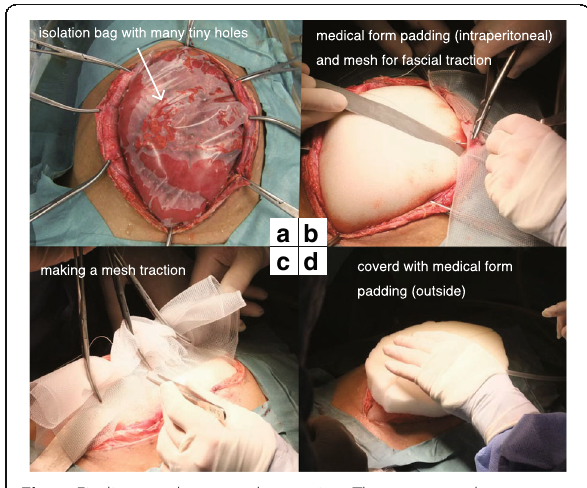
Fig. 4 Findings at the second operation. The gut was edematous and the wound could not be closed. Thus, mesh traction was performed. a The gut edema did not improve at all. b , c Medical form padding (intraperitoneal) was introduced and mesh fascial traction was performed. d We covered the mesh traction with medical form padding